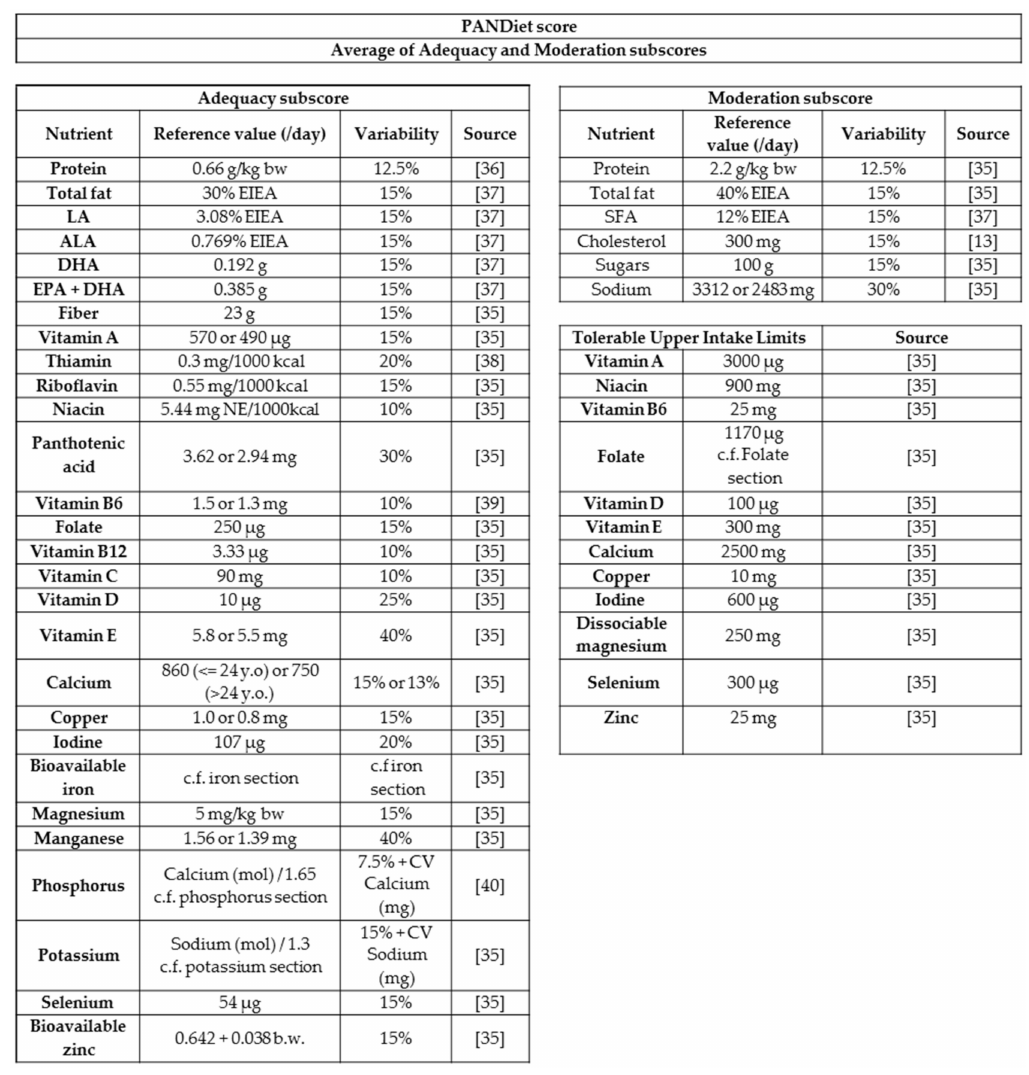
Figure 1. The PANDiet score, expressed as the average of an adequacy subscore (accounting for 28 nutrients), and a moderation subscore (accounting for six nutrients, plus 12 potential penalty values). DHA and EPA + DHA are weighted by 1 ⁄ 2 1 as DHA is counted twice. Niacin equivalents were 2 calculated as the sum of dietary niacin and 1/60 dietary tryptophan. The upper reference value for sugars excludes lactose. The tolerable upper intake limit for vitamin A concerns retinol only. ALA, Alpha Linolenic Acid. DHA, Docosahexaenoic Acid. EIEA, Energy Intake Excluding Alcohol. EPA, Eicosapentaenoic acid. LA, Linoleic Acid. NA, Niacin Equivalent. SFA, Saturated Fatty